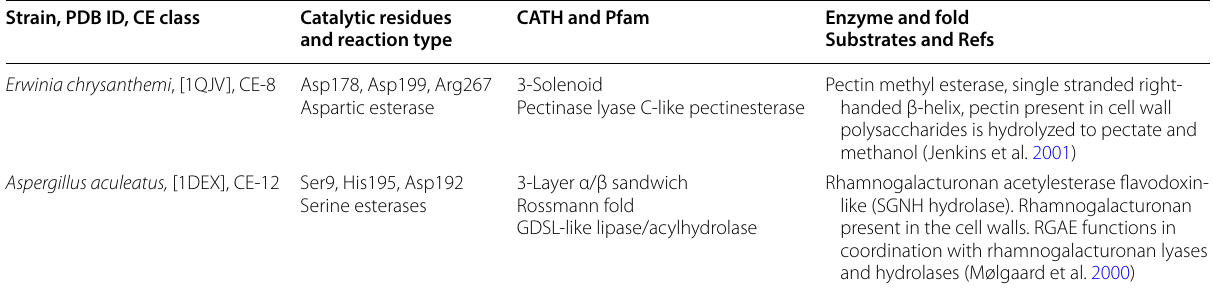
Table 3 List of the structural and functional properties of pectin-deacetylating esterases belonging to CE-8 and CE-12 of carbohydrate